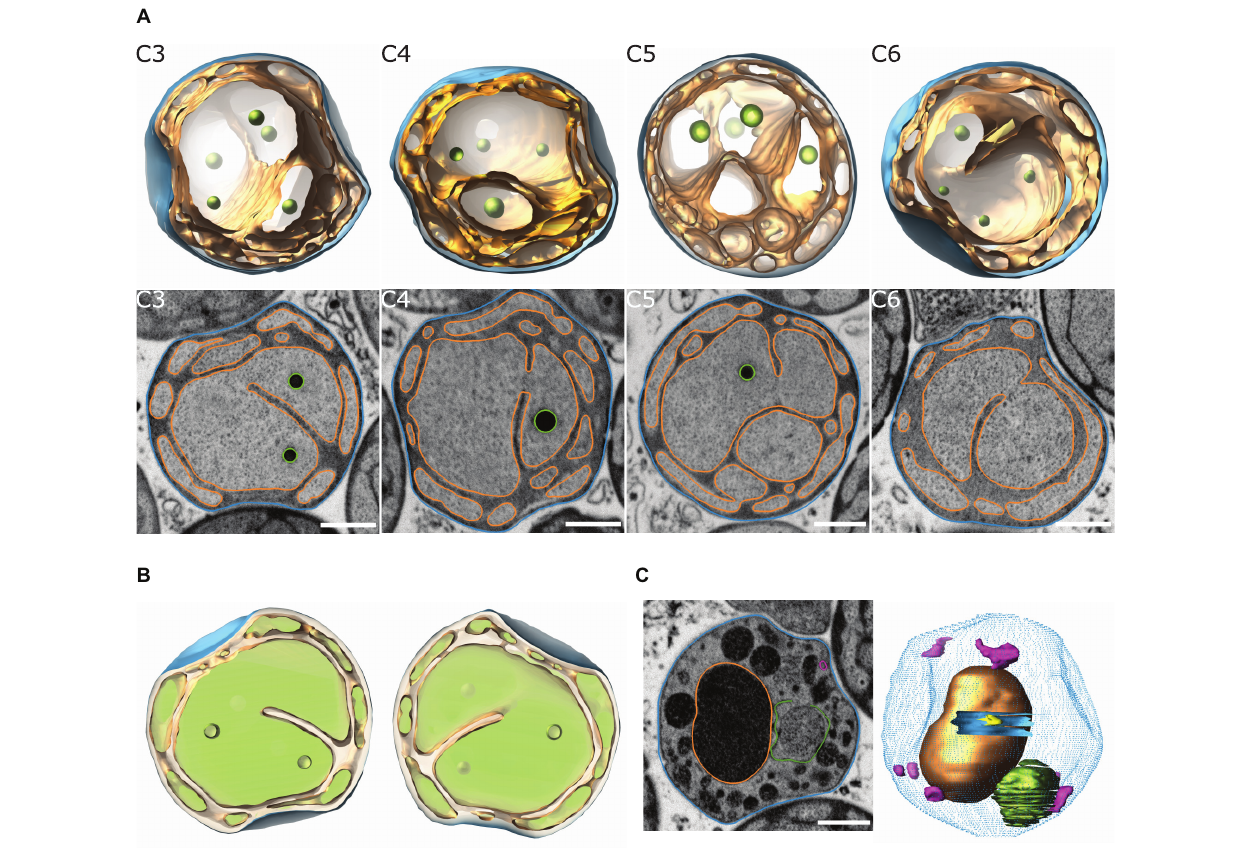
FIGURE 1 | Reconstruction of T. immobilis cell structures based on FIB-SEM analysis. (A) Snapshots of 3D-model (top) and segmented SEM micrographs (bottom) of 4 manually segmented cells (“C3,” “C4,” “C5,” “C6”) depicting the cytoplasmic membrane (orange) and cell envelope (blue). Scale bar: 500 nm. (B) “Filled” model view of cell “C3” at y = 0 ◦ and y = 180 ◦ to illustrate cytoplasmic space (light green) and periplasmic space (light orange). (C) Snapshot of segmented SEM micrograph (left) and partially reconstructed model (right) of cell displaying signs of membrane damage and lysis (blue dotted contour: cell envelope; blue solid mesh: membrane hole; pink mesh: empty membrane vesicles; green: ruptured membrane vesicle). Scale bar: 500